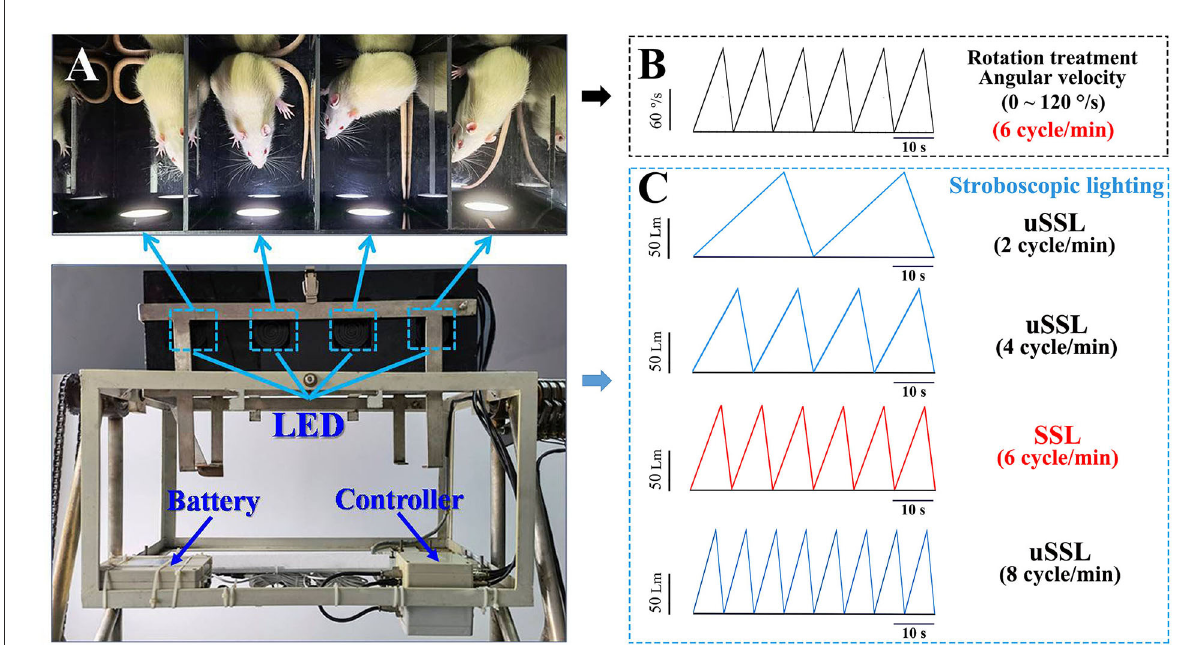
FIGURE1 Images illustrating the manner of stroboscopic lighting treatment during the Ferris wheel-like rotation in rats. (A) Top view of the plexiglass box of the rotation device that was equipped with four sets of LEDs mounted on the side wall of four separate chambers. The LEDs were connected to a controller which was used to set lighting parameters prior to the experiment. The stroboscopic light system was powered by a lithium battery fixed on the frame of the rotation device. (B) The schematic diagram showing the change of rotation angular velocity (120 ◦ /s at peak) and (C) stroboscopic light intensity (100Lm at peak) as a function of time during rotation treatment in Experiment 1. LED emitting rate was set in synchronized (6 cycle/min, light intensity was represented by red lines) or unsynchronized (2, 4, and 8 cycle/min; light intensity was represented by blue lines) manners relative to the acceleration–deceleration rotation circle. The color temperature was set at 6,000 and 3,000K as cool and warm light, respectively. The peak light intensity was adjusted as requested in Experiment 2 (50, 100, or 200Lm) and Experiment 3 (100Lm). LED, light-emitting diode; SSL, synchronized stroboscopic light; uSSL, unsynchronized stroboscopic light.